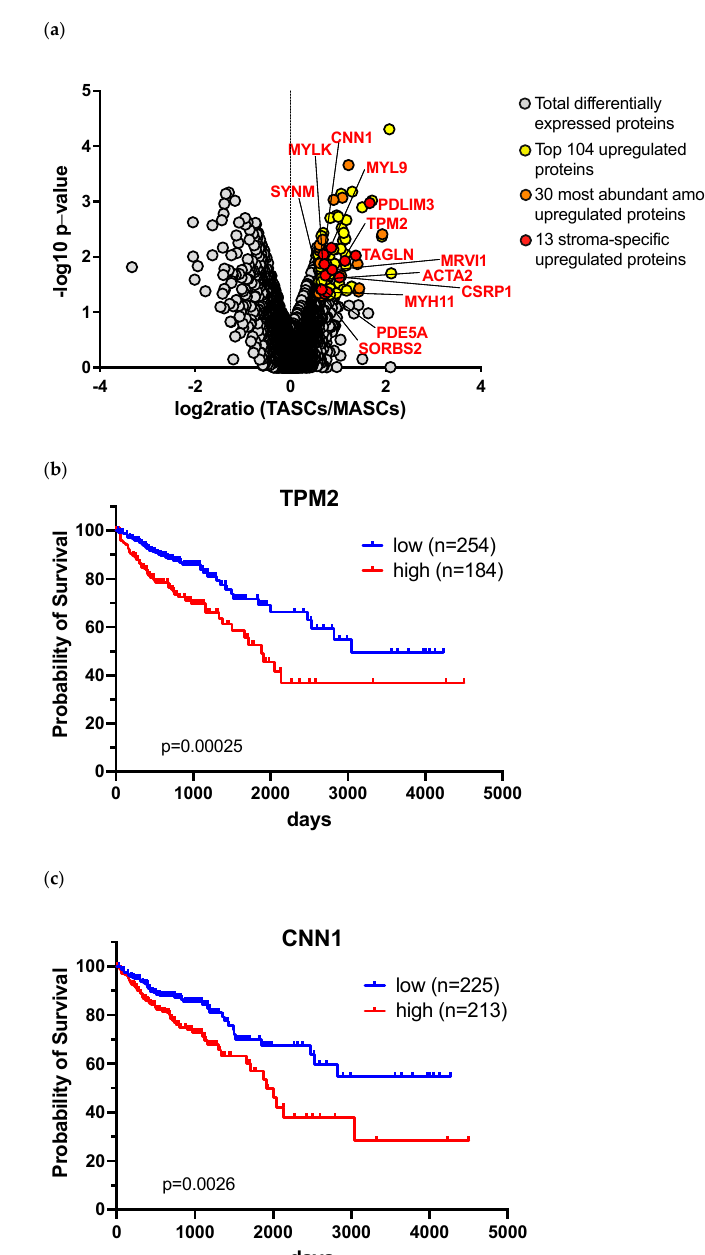
Figure 5 . Proteomic analysis identifies proteins overexpressed in TASCs as compared to MASCs of high prognostic significance. ( a ) Volcano plot illustrating proteins overexpreseed in TASCs as compared to matched MASCs. ( b,c ) Kaplan–Meier plots showing survival probability in colon cancers with high (red line) or low (blue line) expression of ( b ) TPM2 or ( c ) CNN1 in colon cancer samples of the TCGA COAD cohort ( n = 438), classified according to best expression cut-off. p values were estimated by log-rank test.